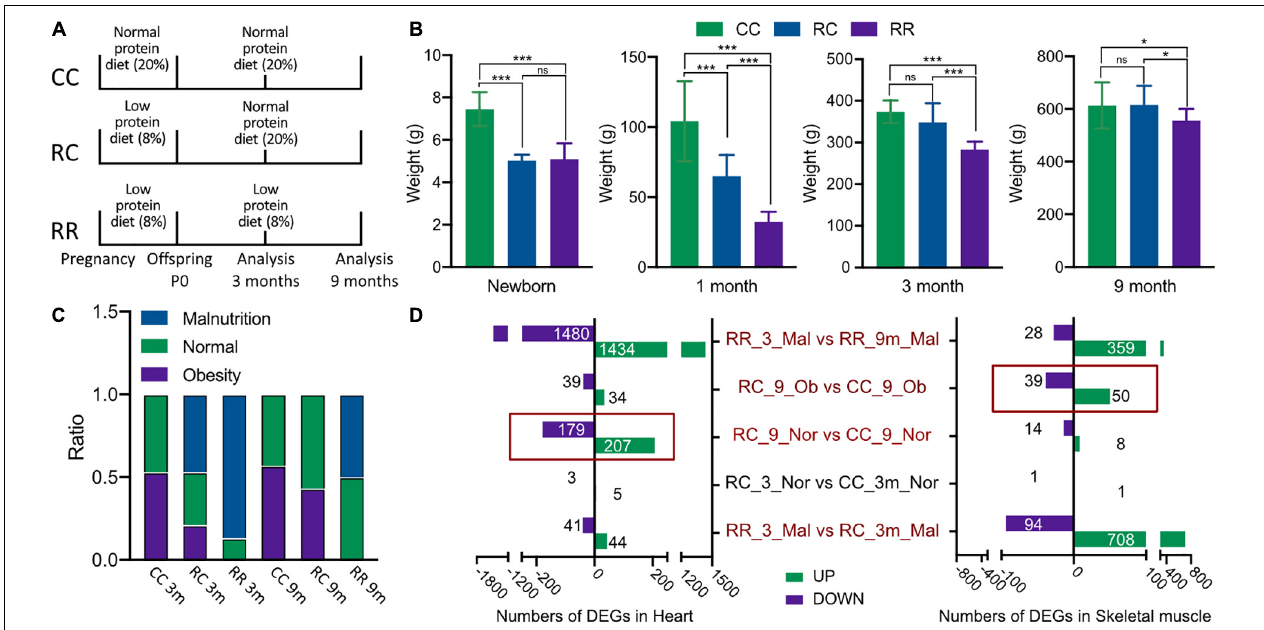
FIGURE 1 | Low-protein diet in pregnancy resulted in fetal IUGR. The impacts of IUGR remain for long-term to impair the metabolism of cardiac and skeletal muscle. (A) The feeding protocols among different groups and the time point for sample harvest. (B) The average body weights among RC, RR, and CC groups at different follow-up time points, which demonstrated that the normal protein diet feeding would help the offsprings with IUGR to achieve standard adulthood body weight. (C) The formation of nutrition status of rats among various experimental groups. (D) Number of differentiated expressed genes (DEGs) identified in five comparisons of cardiac and skeletal muscles. * p < 0.05, *** p <